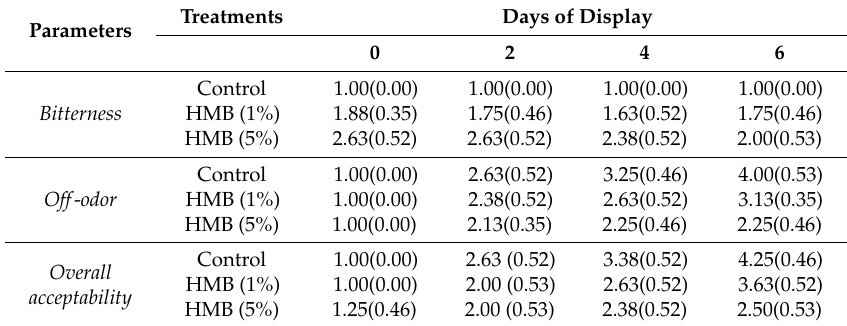
Table 3. Sensory scores* of treated and untreated Halal minced beef (HMB) during period of